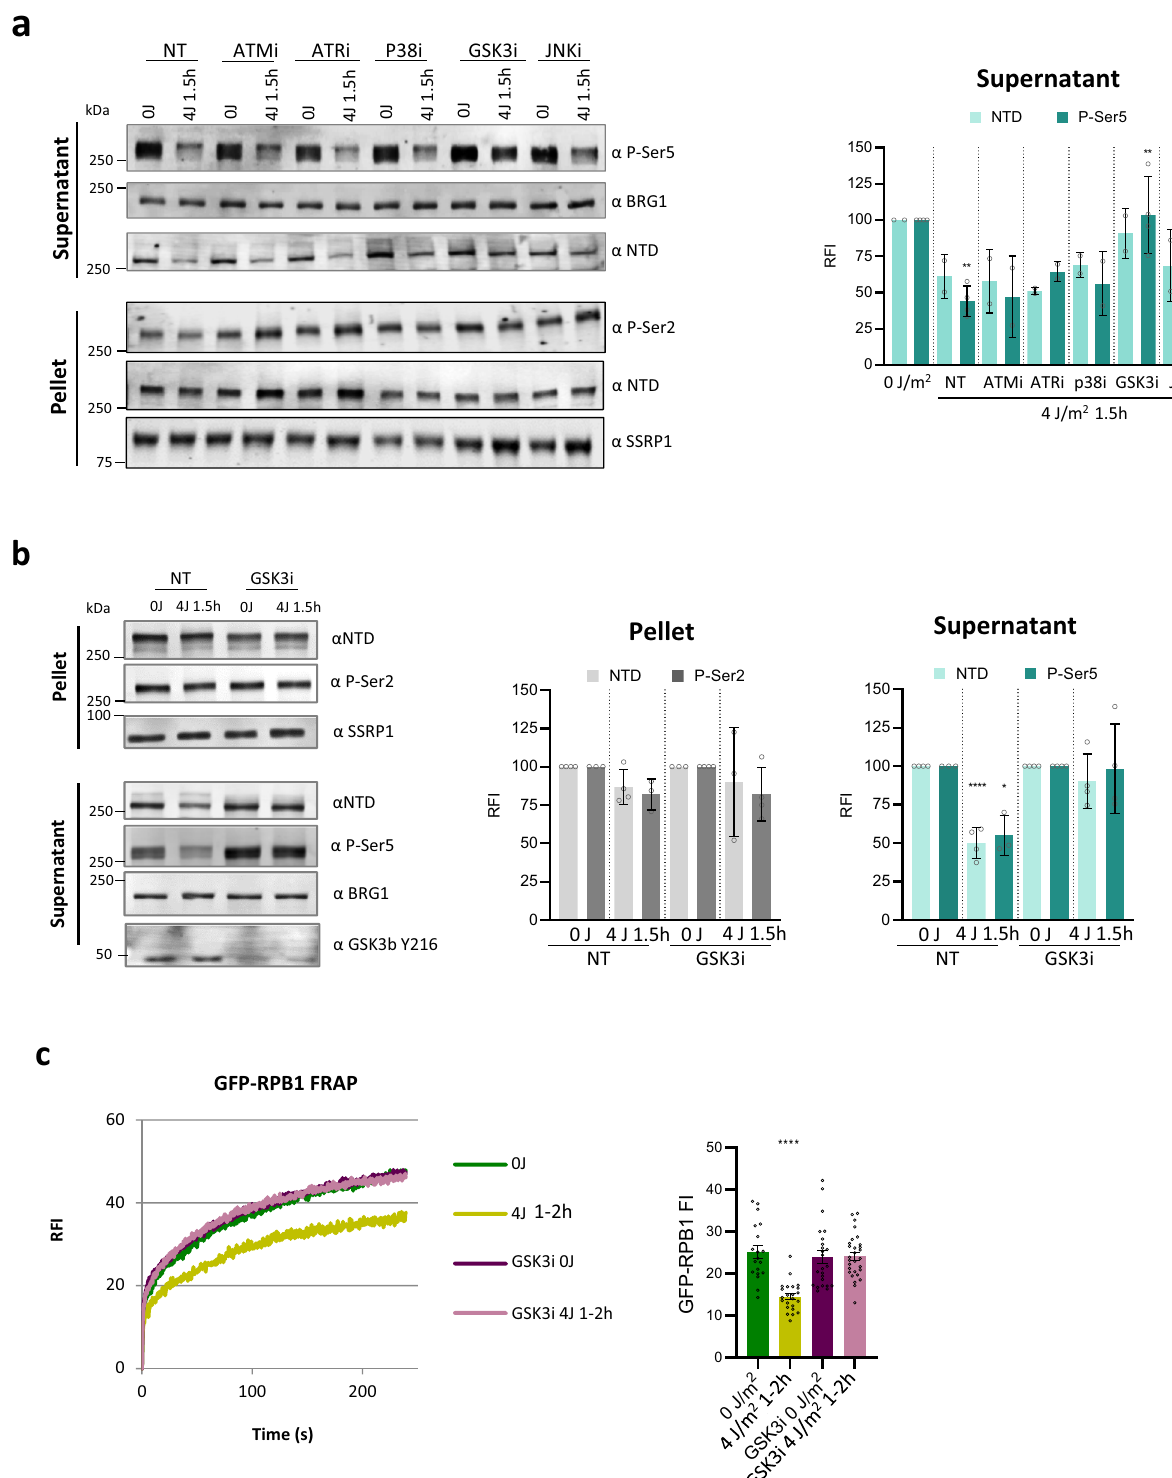
the immobilization 1 h after UV damage induction, due to degradation of promoter-bound Pol II, was absent in GSK3 inhibitor-treated cells (Fig. 5c, left panel). Furthermore, GSK3 inhibition signi fi cantly reduced the UV-induced degradation of total Pol ll levels measured by live-cell GFP-RBP1 fl uorescence (Fig. 5c, right panel), while it did not affect Pol II mobility or levels directly after UV (Supplementary Fig. 4a). Similar results were obtained upon siRNA-mediated depletion of both